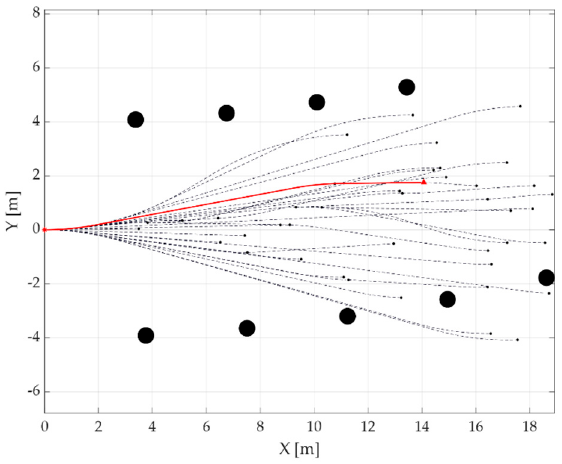
Figure 9. Generated path (solid, red) and search tree expansion (dashed, black) for a left turn, with obstacles (black, dots), starting vehicle position (red asterisk) and goal point (red triangle).